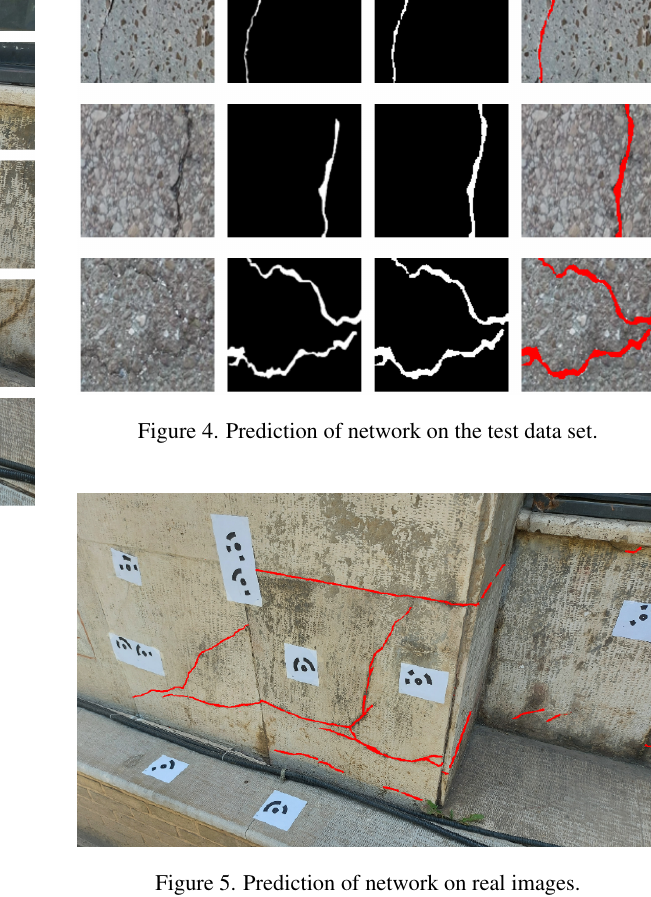
Figure 5. Prediction of network on real